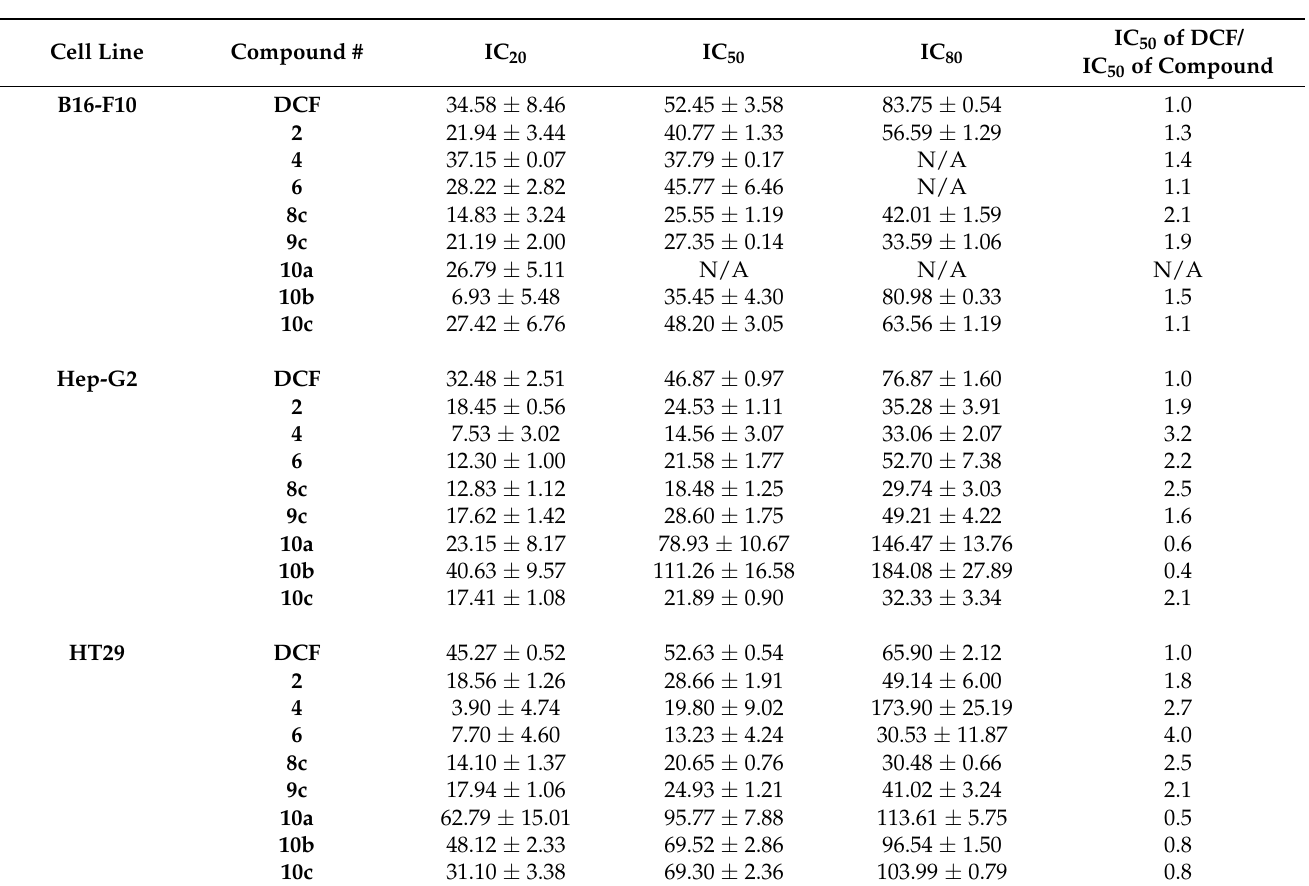
Table 1. Growth-inhibitory effects as IC 20 , IC 50 , and IC 80 ( µ g · mL − 1 ) values of compounds 2 , 4 , 6 , 8c , 9c , 10a - c, and DCF on the three cancer cell lines B16-F10, Hep-G2, and HT29. The last column represents the ratio between IC 50 values of DCF and the corresponding